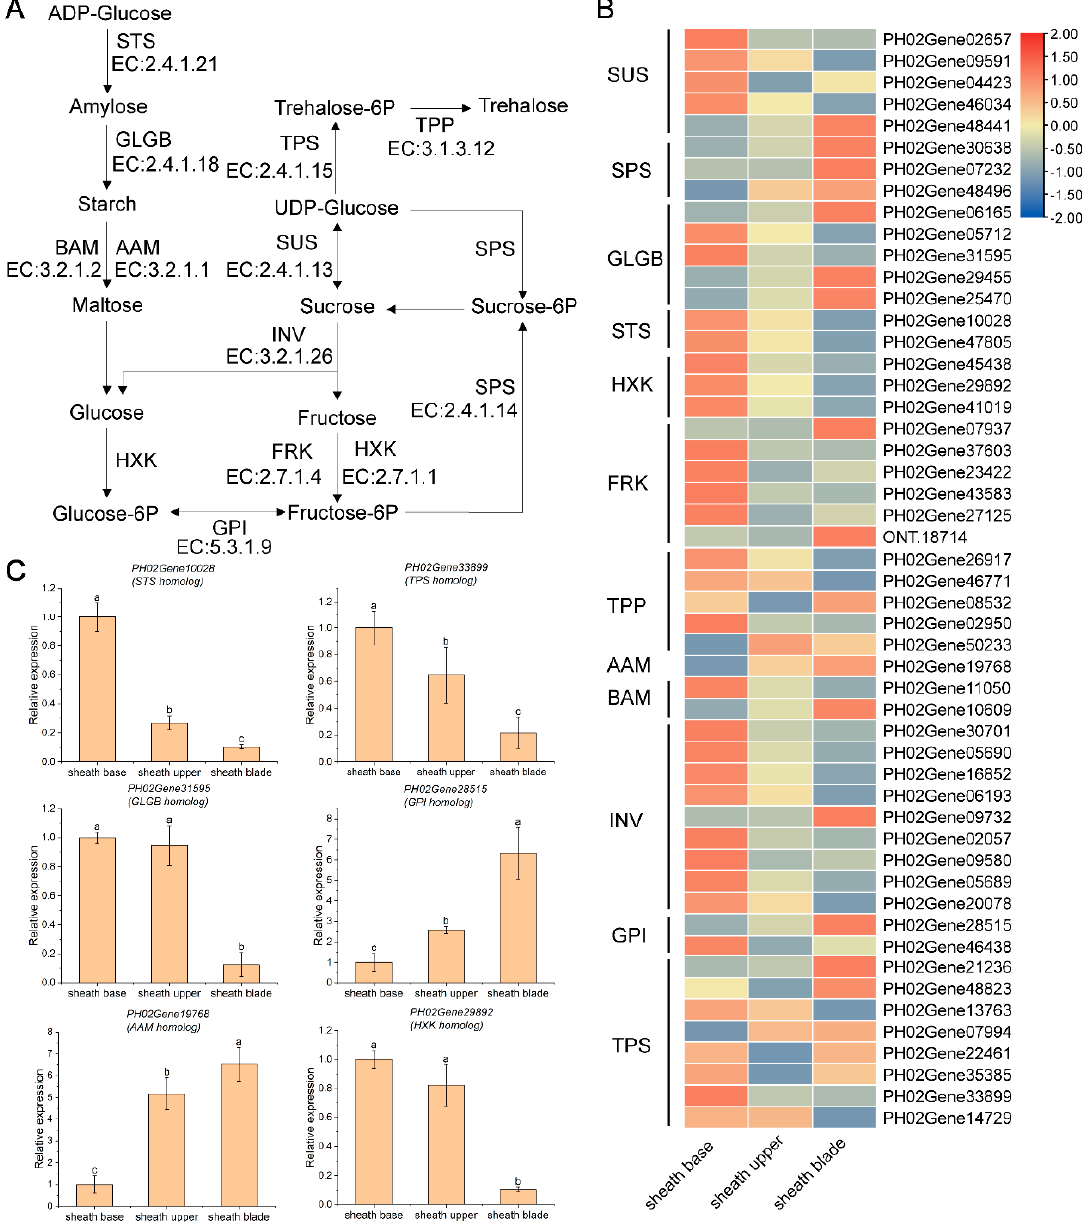
Figure 7. Expression changes in starch and sucrose metabolism pathway-related differentially expressed genes (DEGs) in the culm sheath. ( A ) Schematic diagram of starch and sucrose metabolism. ( B ) Heatmap of differential expression of key enzymes in starch and sucrose metabolism. STS, starch synthase; GLGB, 1,4-alpha-glucan branching enzyme; AAM, alpha-amylase; BAM, beta-amylase; HXK, hexokinase; GPI, glucose-6-phosphate isomerase; FRK, fructokinase; INV, beta-fructofuranosidase; SUS, sucrose synthase; SPS, sucrose-phosphate synthase; TPS, trehalose 6-phosphate synthase/phosphatase; TPP, trehalose 6-phosphate phosphatase. ( C ) RT-qPCR analysis of the expression pattern of specific DEGs of starch and sucrose metabolism pathway. The ID name of each DEG is placed at the top of the panel. Different letters indicate significant differences between the average values of the column (±SE, n = 3), p < 0.05.